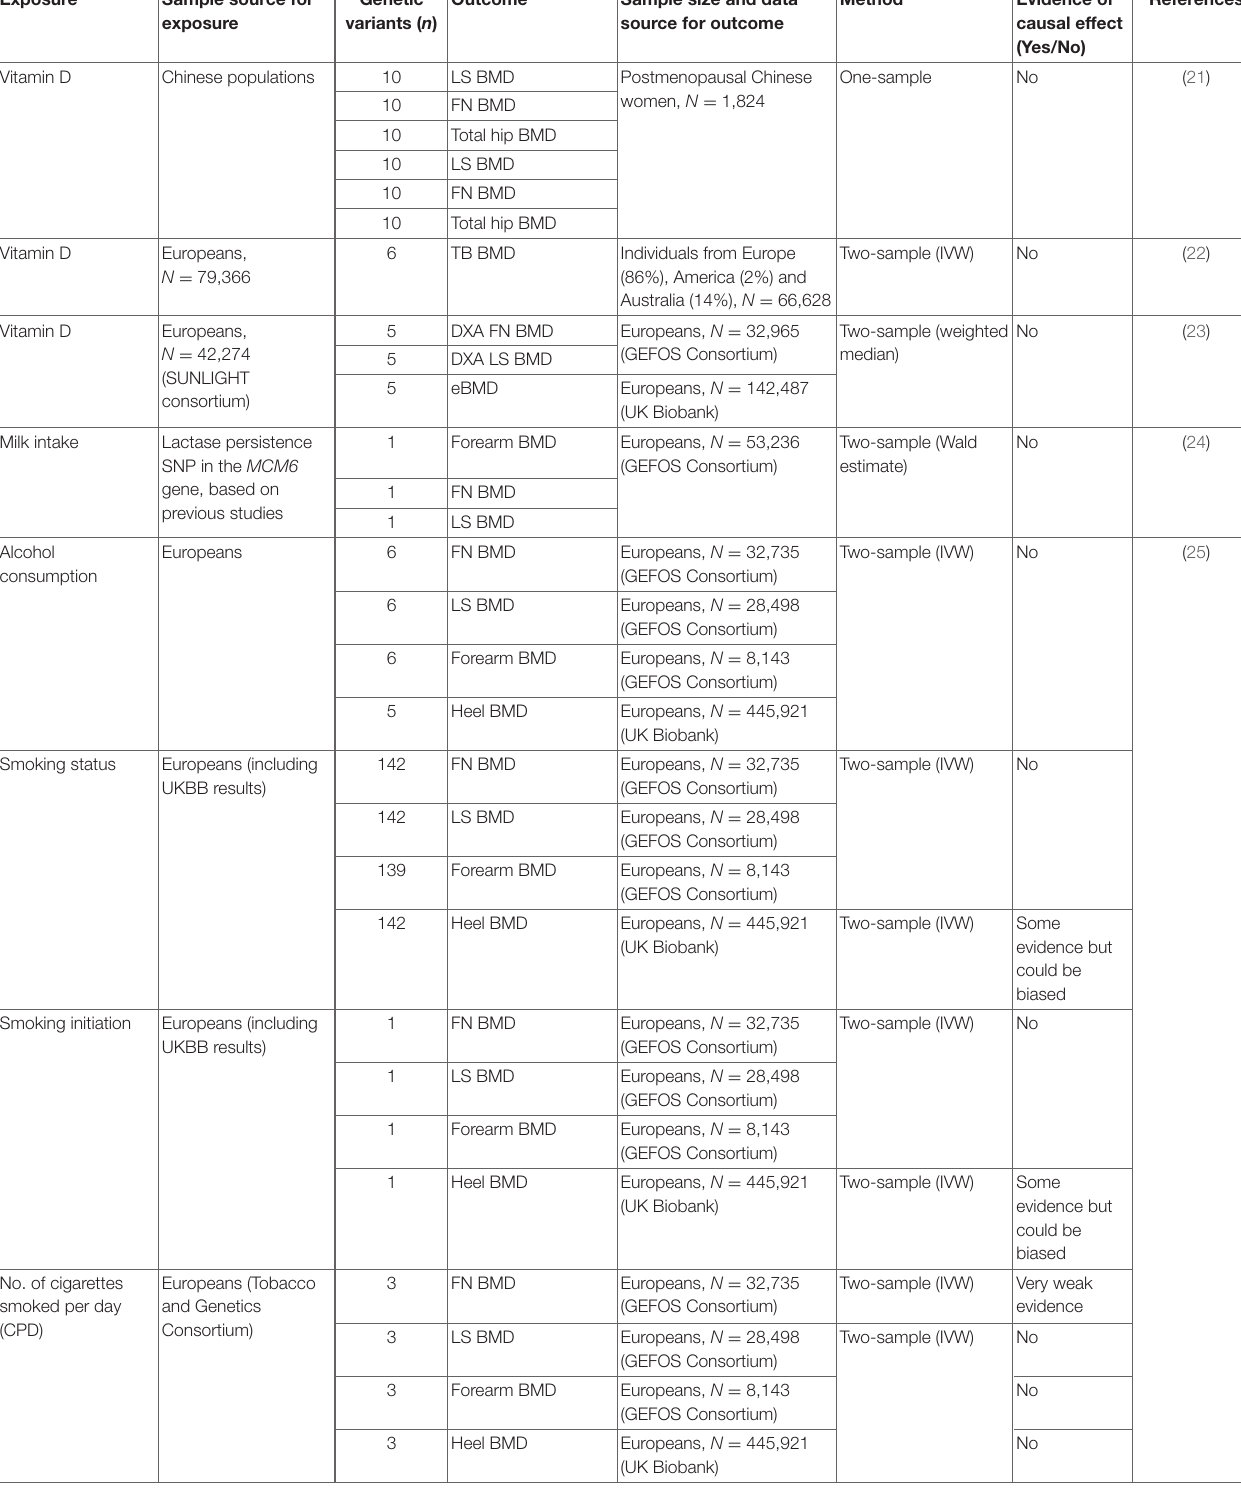
TABLE 1 | Examples of studies investigating causal associations between risk factors and BMD.